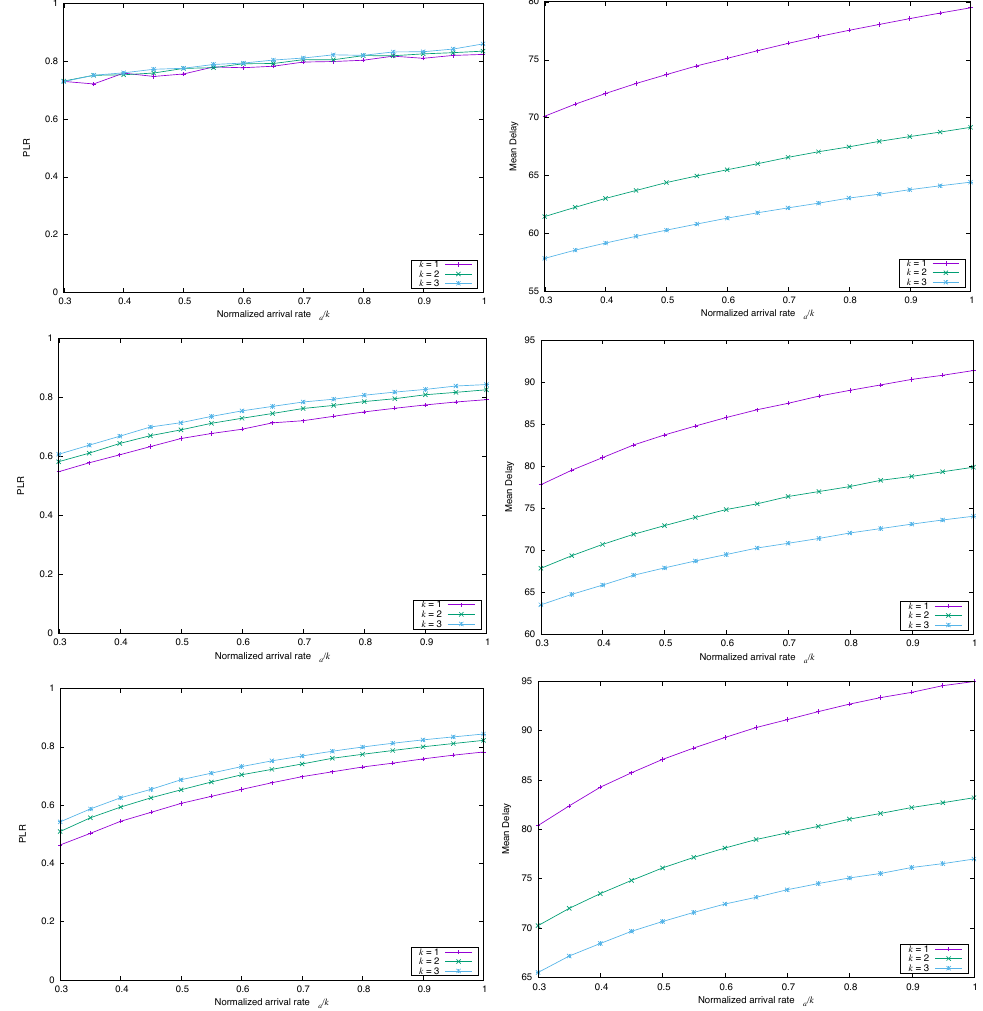
Figure 6. Simulated PLR ( top ) and Mean Delay ( bottom ) for FS-CSA versus λ a / k , with Λ ( x ) = 0.86 x 3 + 0.14 x 8 , n = 200 and k = { 1,2,3 } , and marginal distribution Pareto, with α = 1.1 ( top-left ), α = 1.5 ( top-right ) and α = 1.9 ( bottom